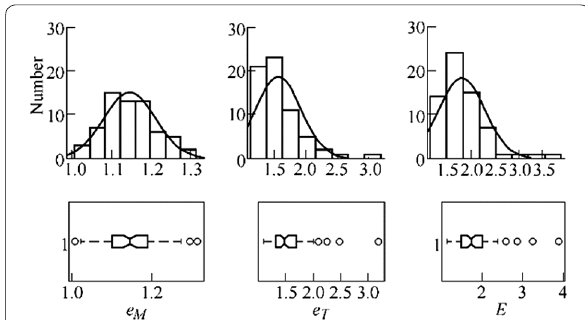
Figure 8 Histograms and box plots for LPG, I and II generation engine groups